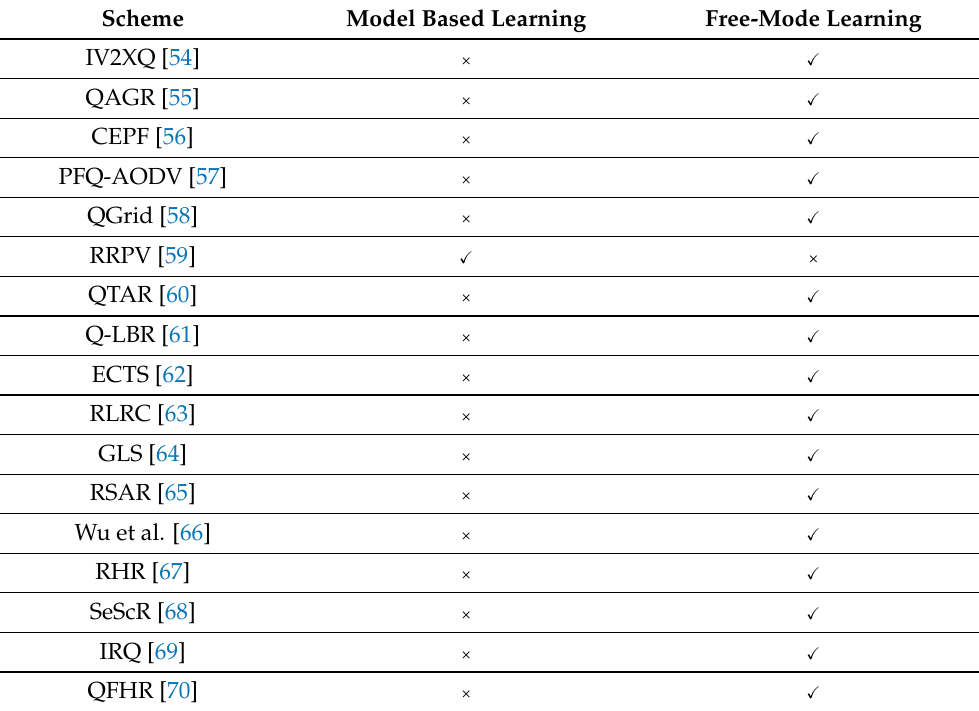
Table 13. Comparison of RL-based routing methods in terms of learning